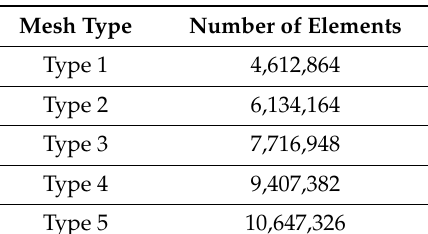
Table 4. Experimental results for the maximum heat generation rate at 1C, 2C discharge rates and the different boundary conditions [20].